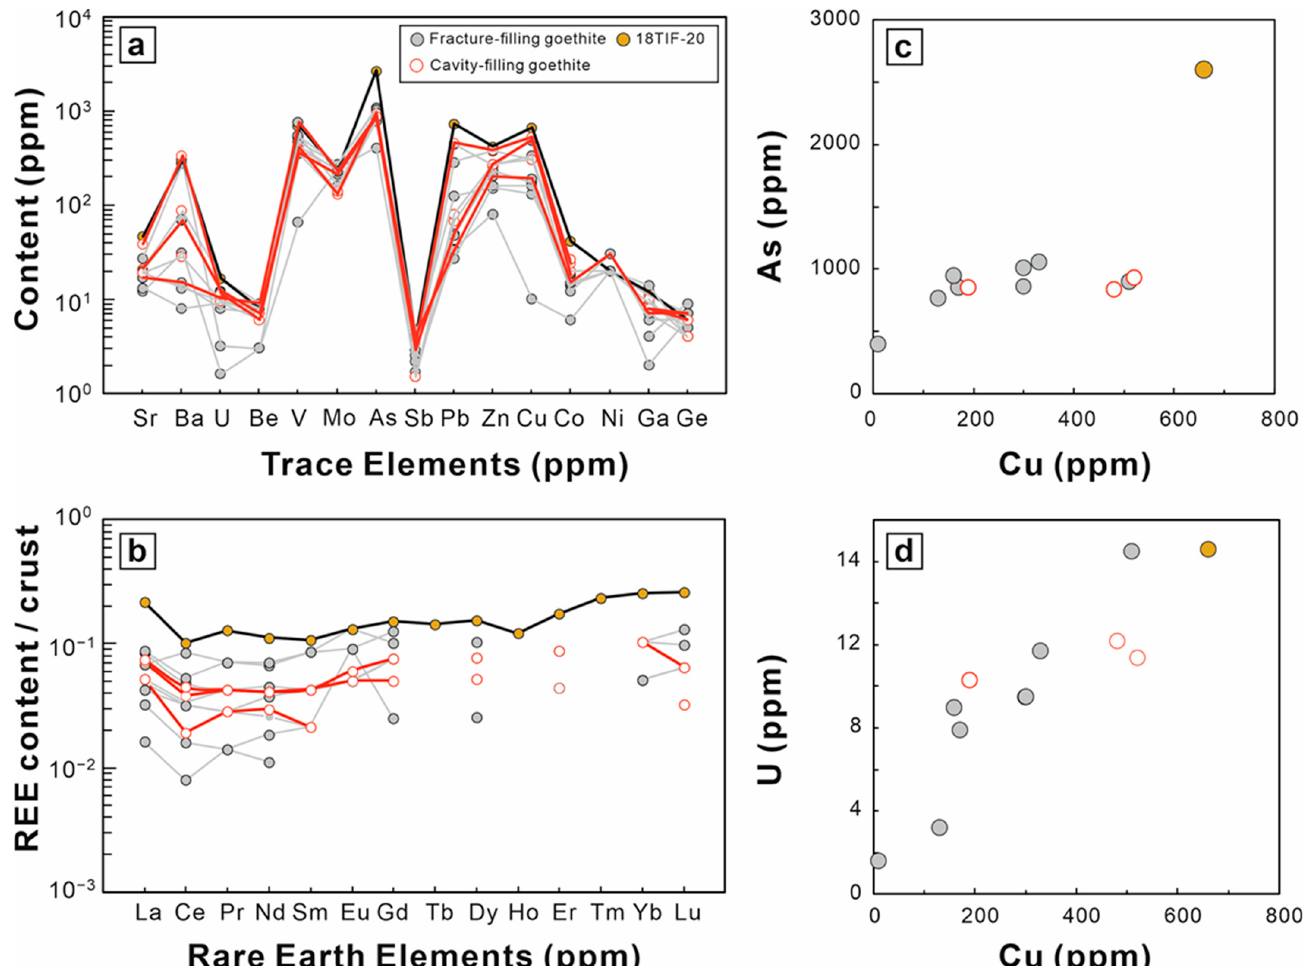
Figure 6. Geochemical data of Far West, Tifersine and Plateaux samples. ( a ) Trace element patterns; ( b ) rare earth element patterns normalized to the continental crust; ( c ) As vs. Cu contents and ( d ) U vs. Cu contents. The fracture-filling goethite is reported using gray circle symbols, except for 18TIF-20 where yellow-gray color is used, and the cavity-filling goethite is reported with a red open circle symbol.